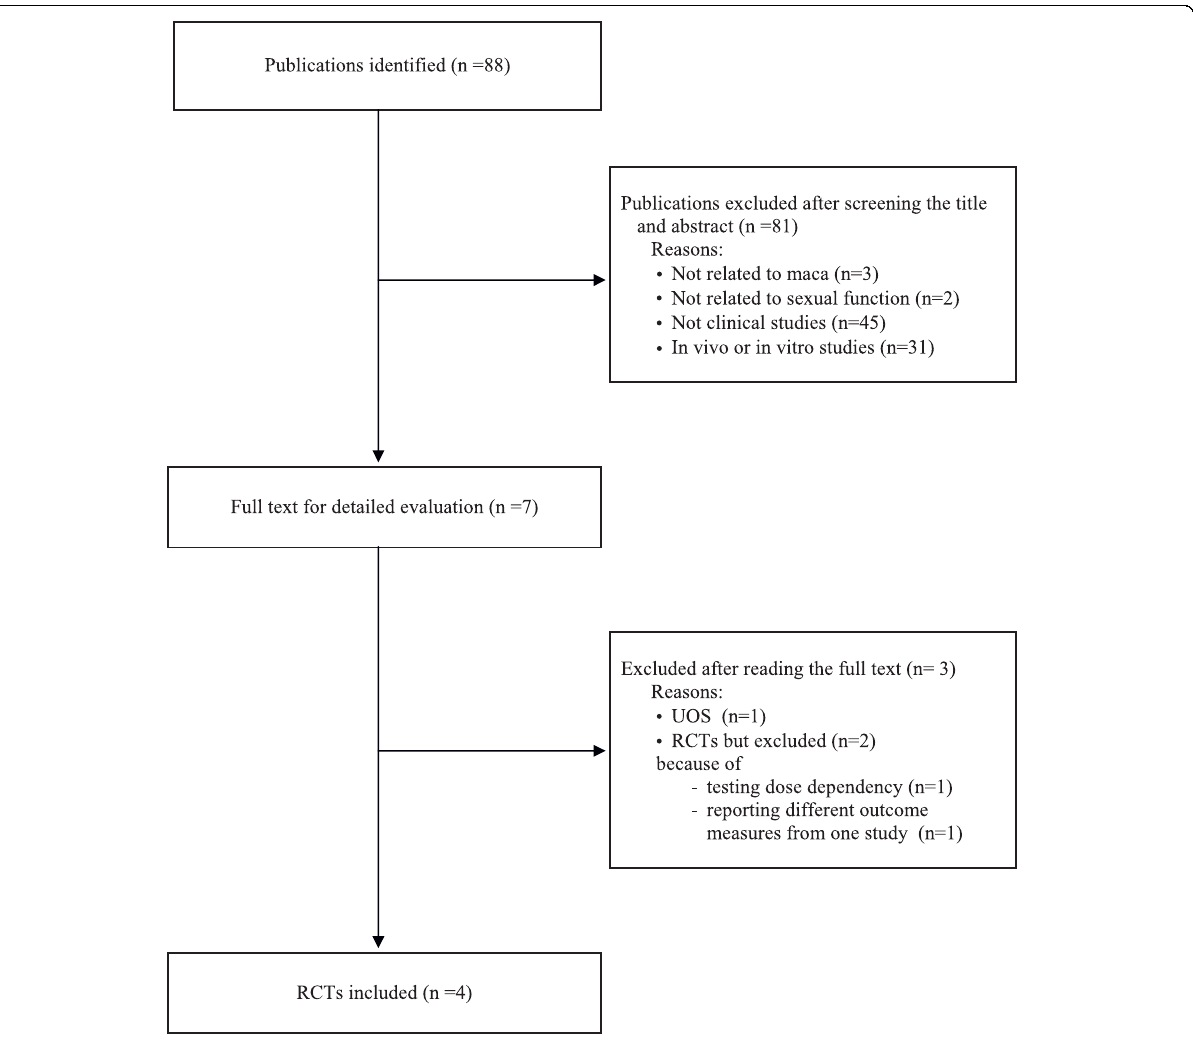
Figure 1 Flow chart for the selection of included trials . RCT: randomised clinical trial; UOS: uncontrolled observational